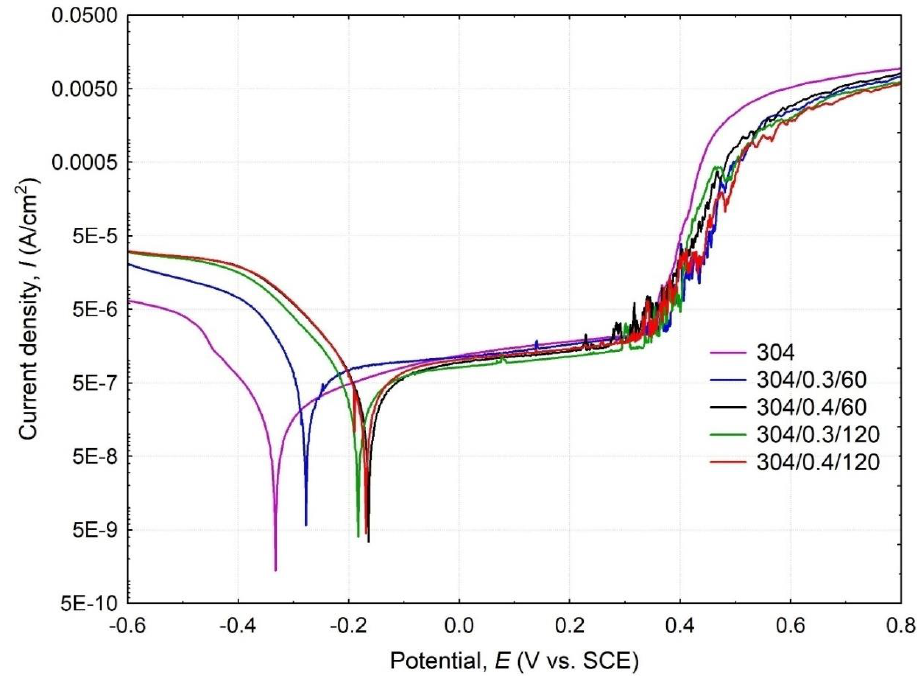
Figure 6. Potentiodynamic polarization curves under open circuit potential condition for reference (304) and shot-peened stainless steel samples in 3.5% NaCl solution. Table 4. Results of electrochemical corrosion reported for unpeened and shot peened AISI 304 steel.